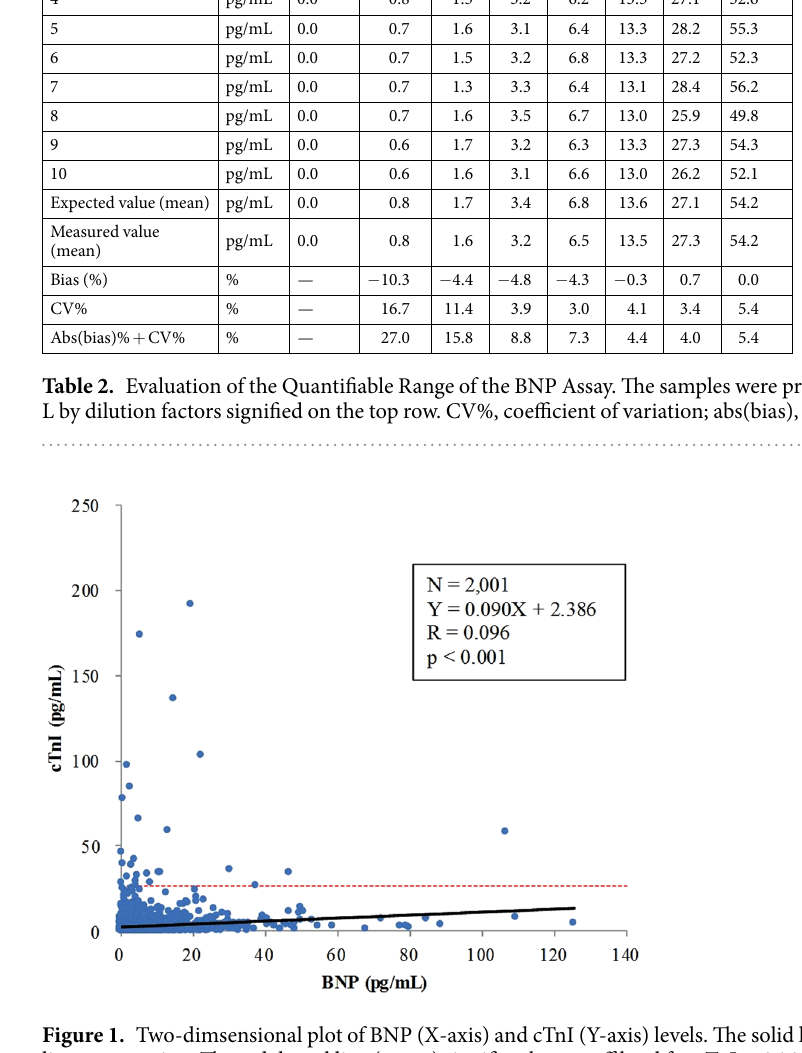
Figure 1. Two-dimsensional plot of BNP (X-axis) and cTnI (Y-axis) levels. The solid line ( ) signifies linear regression. The red dotted line ( ) signifies the cut-off level for cTnI at 26.2 pg/mL. BNP, B-type natriuretic peptide; cTnI, cardiac troponin I; WC, waist circumference; SBP, systolic blood pressure;